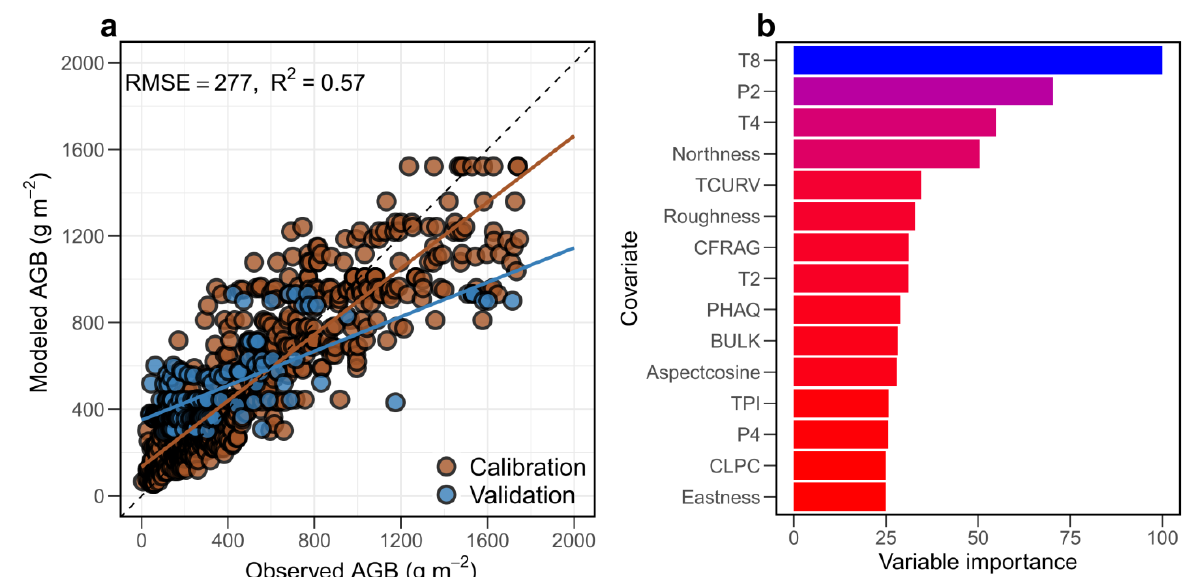
Figure 6. Performance of the fitted random forest model to predict aboveground biomass (AGB) ( a ) and the relative importance of the top 15 most important variables for predicting AGB ( b ). See Table A1 for detailed descriptions of the variables.